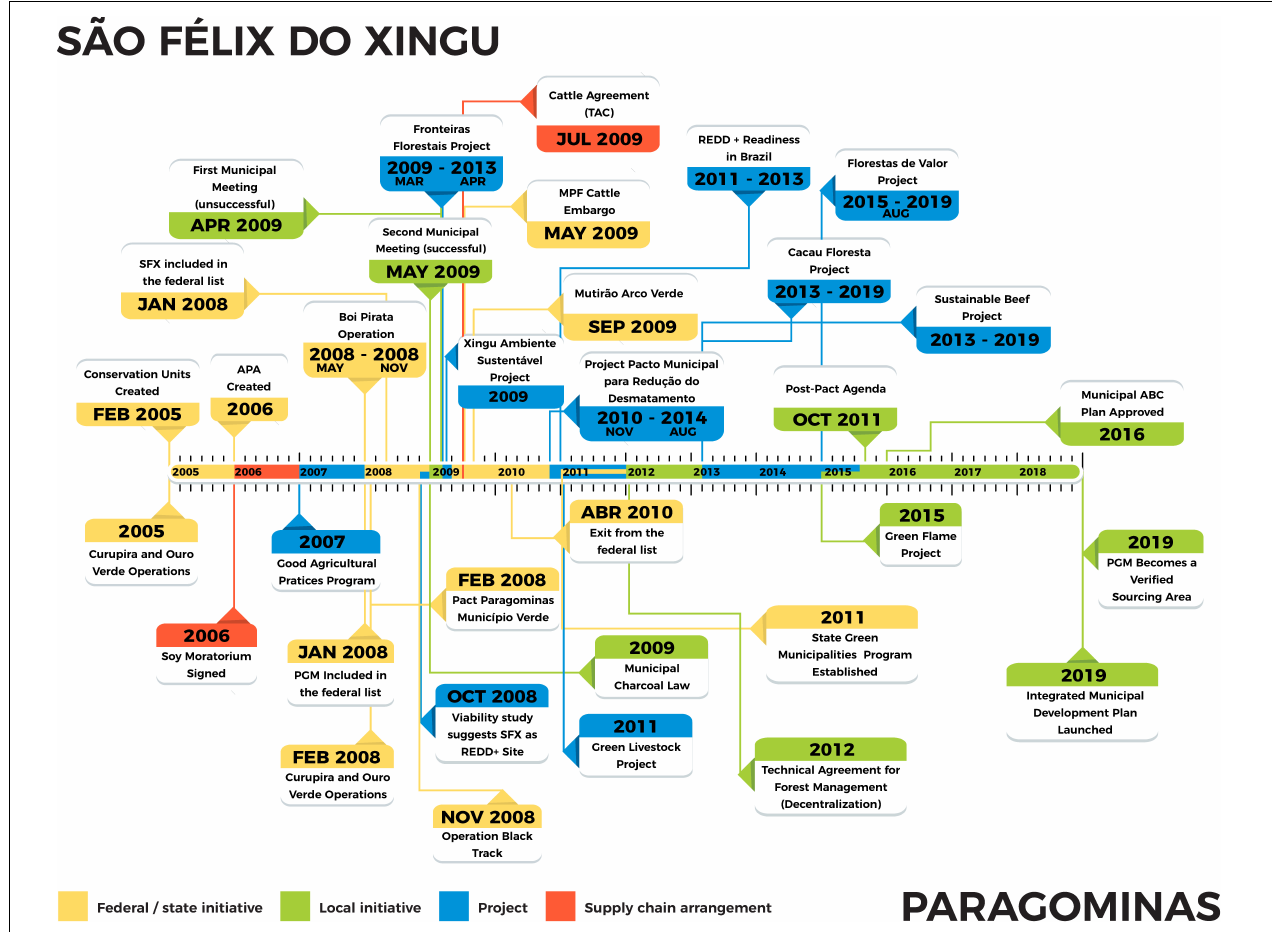
FIGURE 2 | Forest governance timelines.